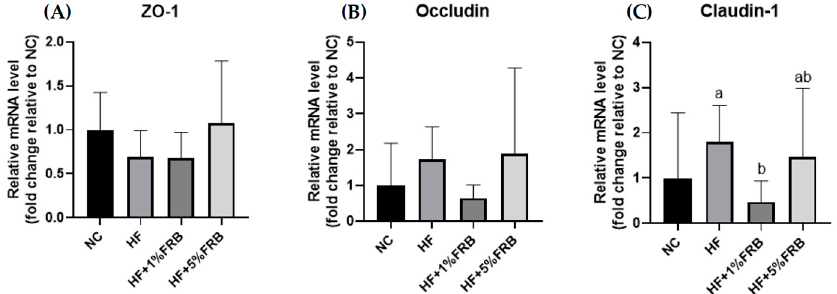
Figure 8. Effects of the water extract of fermented rice bran (FRB) on intestinal zonula occludens (ZO)-1, occludin, and claudin-1 mRNA levels in aged rats with high-fat (HF) diet feeding. Values are presented as the mean ± standard deviation ( n = 6). * p < 0.05 vs. the normal control (NC) group; significance between two groups was determined using Student’s t -test. In the HF diet-fed groups, different letters indicate significant differences between groups at p < 0.05 by a one-way ANOVA with Fisher’s post hoc test. Comparative quantification of each gene was normalized to β -actin using the 2 −∆∆ Ct method, and the ratio of each internal control was calculated by setting the value of the mean of the NC group.